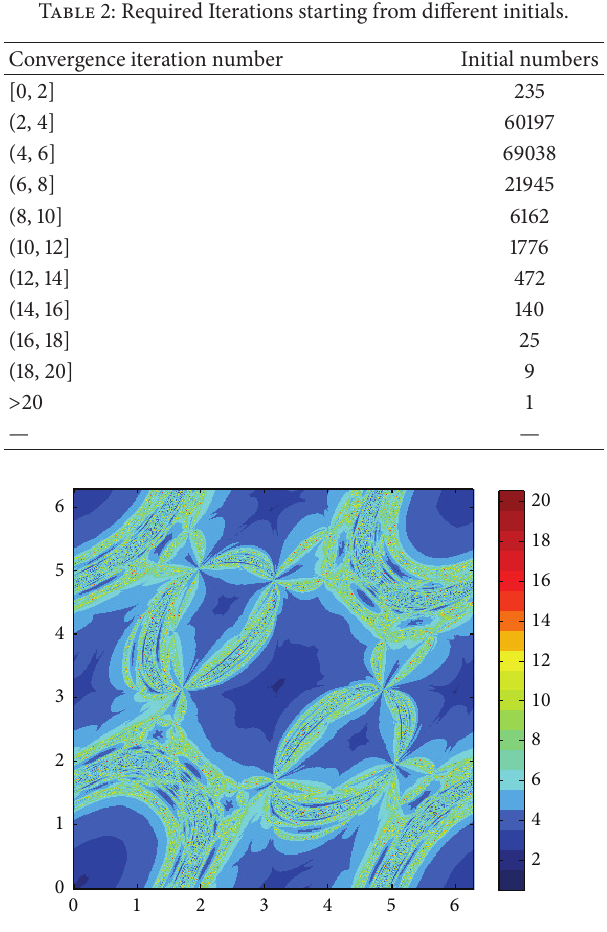
Figure 3: The convergence region and the number of iterations needed for the Newton method on ( 𝜃 2 ,𝜃 3 )